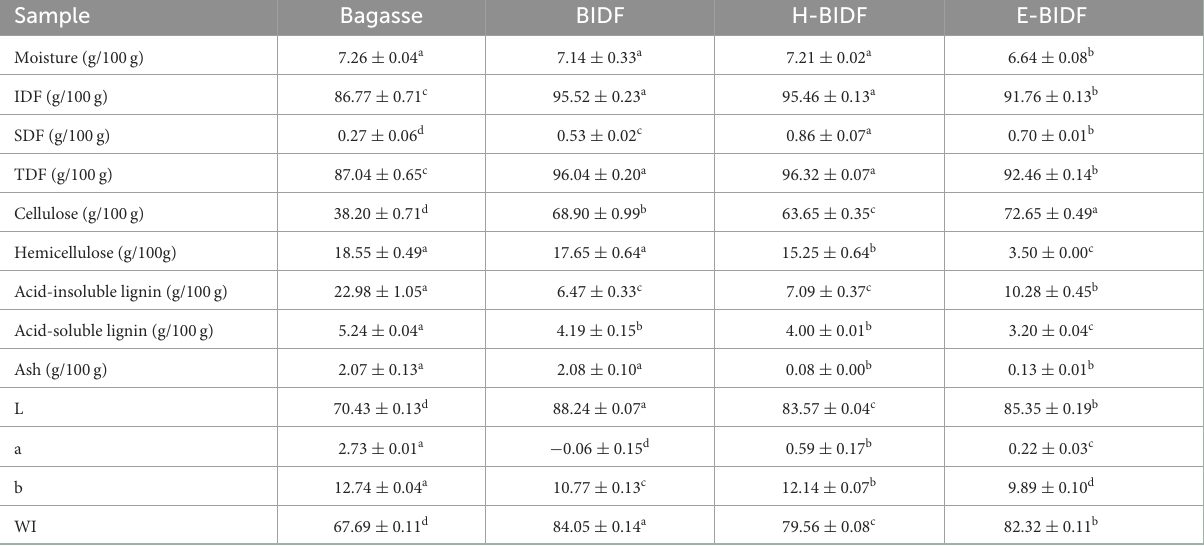
TABLE 2 The approximate chemical composition and color of bagasse insoluble dietary fiber modified by different methods. Sample